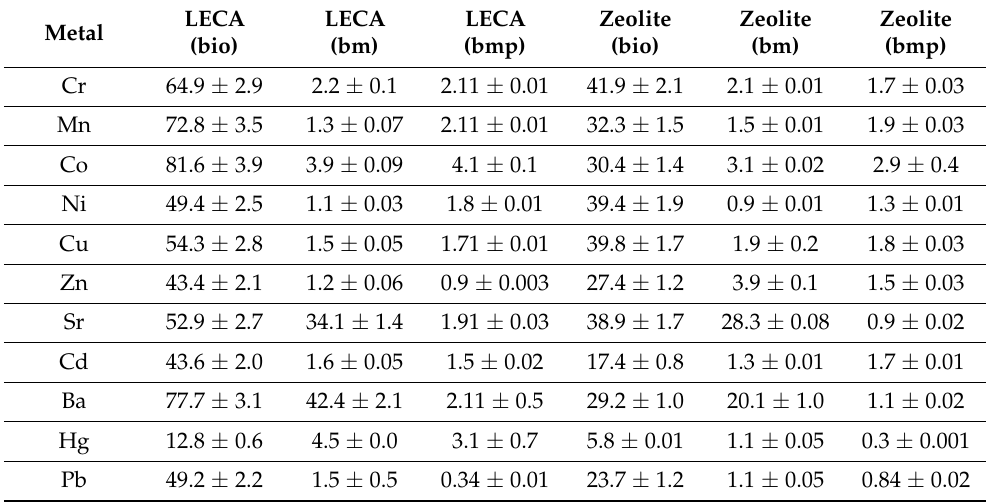
Table 5. Efficiency of metal desorption from the LECA and zeolite using groundwater as a desorbing agent.